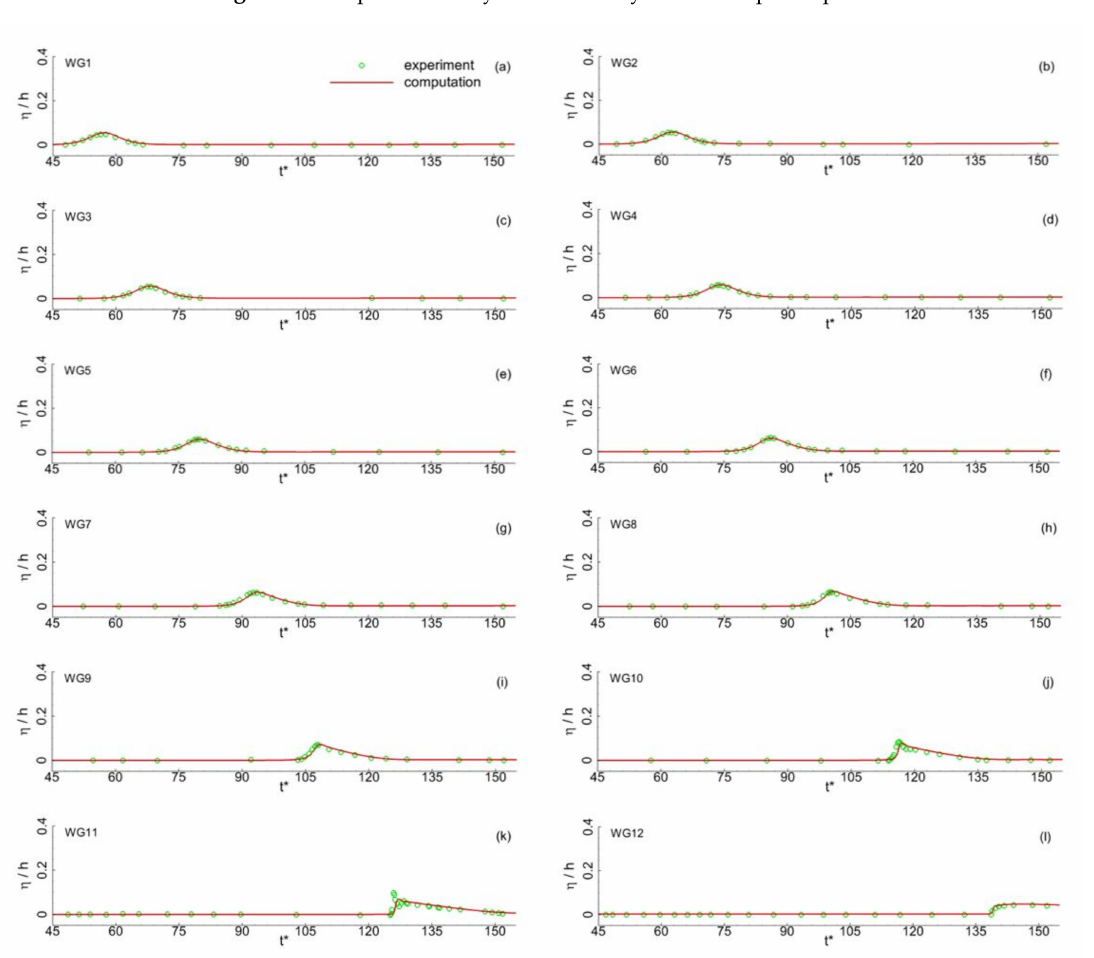
Figure 4. Comparisons of the time series of water surface elevation at different wave gauges for H / h = 0.054; ( a ) WG1; ( b ) WG2; ( c ) WG3; ( d ) WG4; ( e ) WG5; ( f ) WG6; ( g ) WG7; ( h ) WG8; ( i ) WG9; ( j ) WG10; ( k ) WG11; ( l )